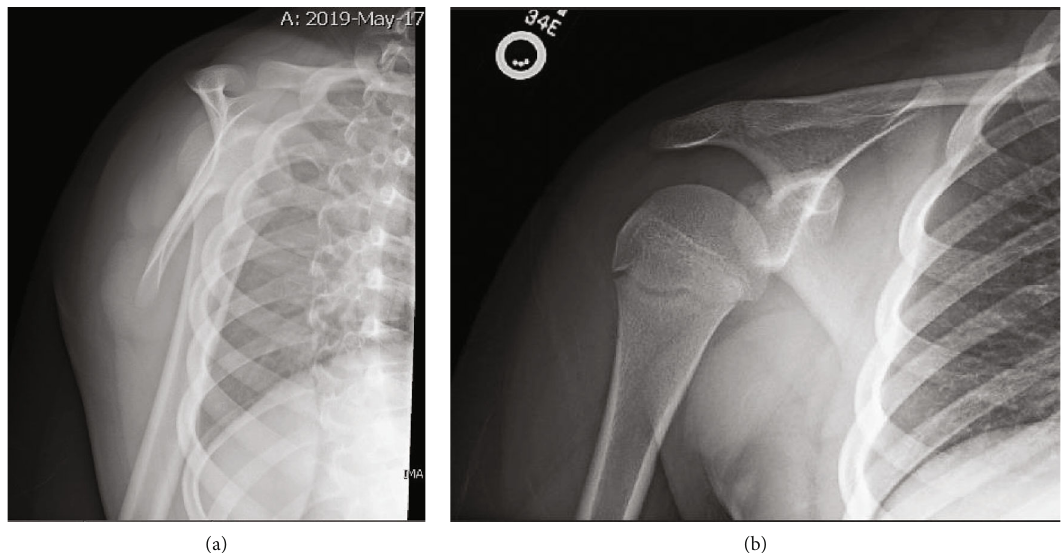
Figure 1: (a) Scapular X-ray taken during patient ’ s fi rst visit to emergency department. (b) Anteroposterior X-ray taken during patient ’ s fi rst visit to emergency